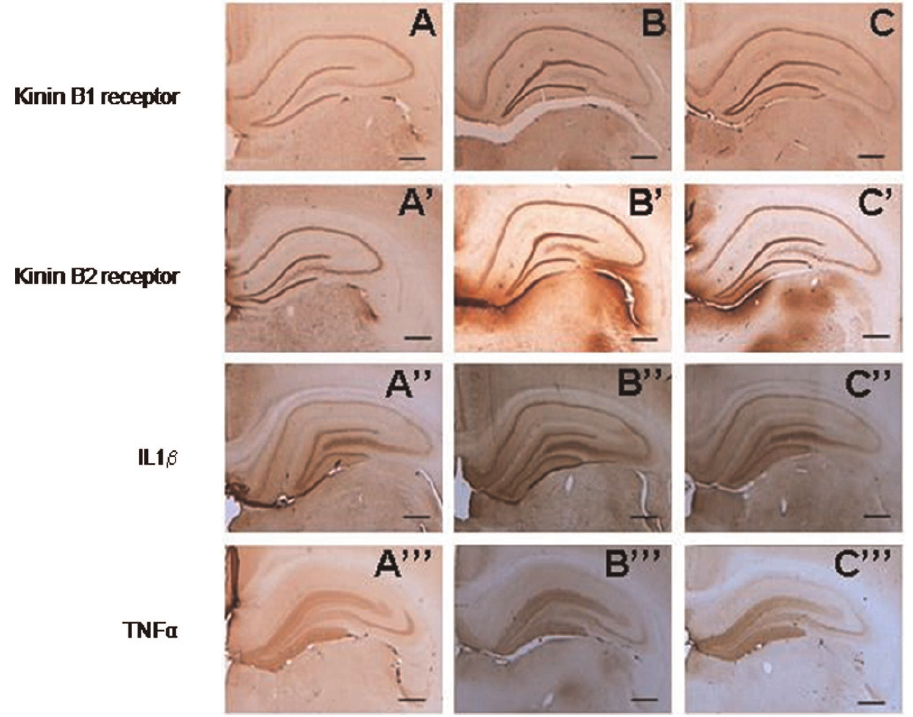
Figure 1 - Photomicrographs of hippocampi processed for immunohistochemistry showing expression of the kinin B1 receptor (A, B and C), the kinin B2 receptor (A’, B’ and C’), IL1 b (A’’, B’’ and C’’) and TNF a (A’’’, B’’’ and C’’’). Groups: A – saline-treated group; B – pilocarpine-treated group; and C – indomethacin-treated group. Scale bars: 0.3